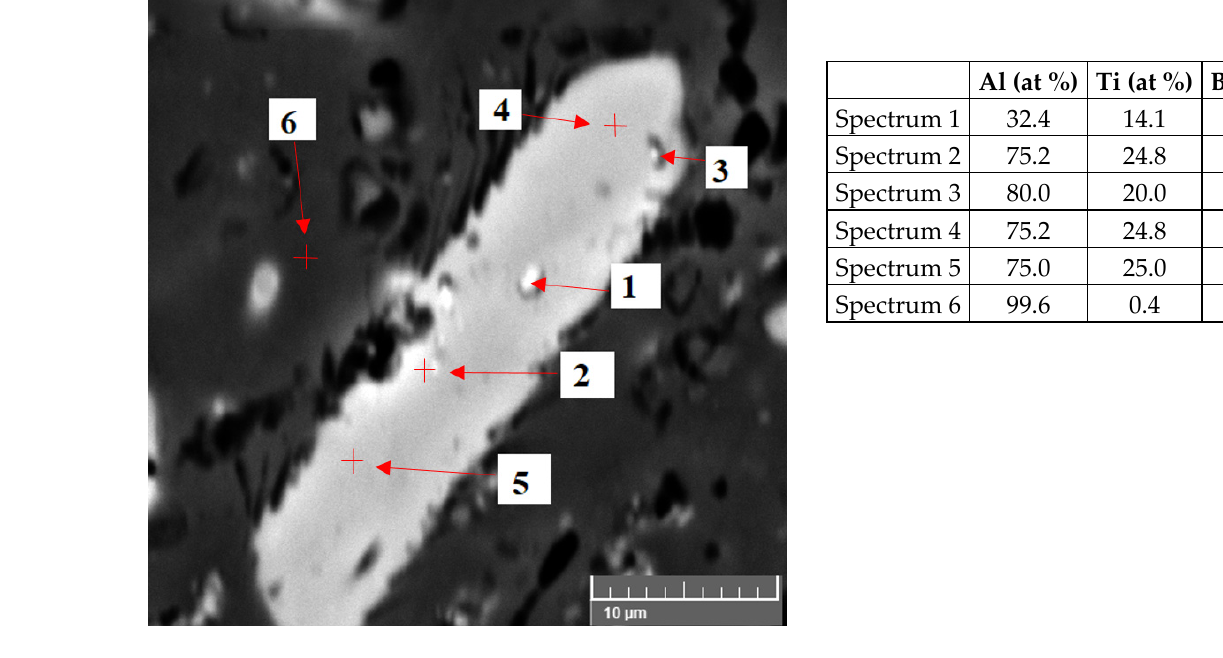
Figure 9. Microstructure of the AlTi5B1 alloy and EDS point analysis.